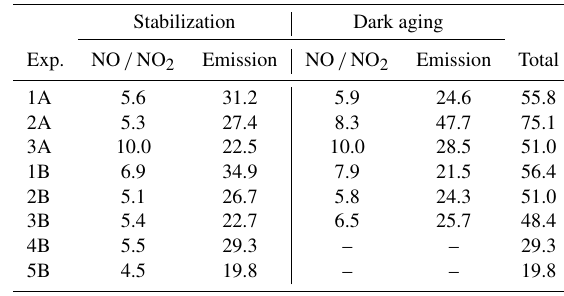
Table 7. Organonitrate (ON) emissions (mgkg − 1 fuel) from log- wood combustion at the end of experimental periods (stabilization and dark aging) calculated using Eqs. (2) and (3) and corresponding NO-to-NO 2